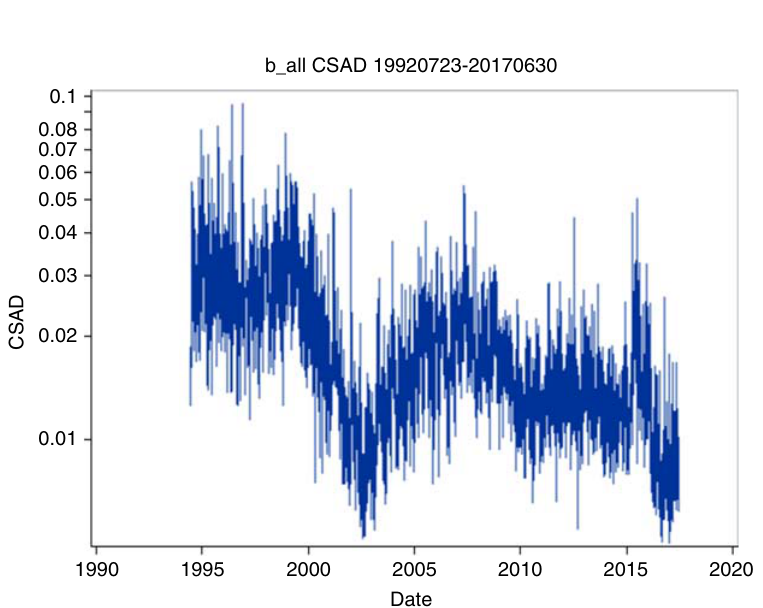
Figure 1. Cross-sectional